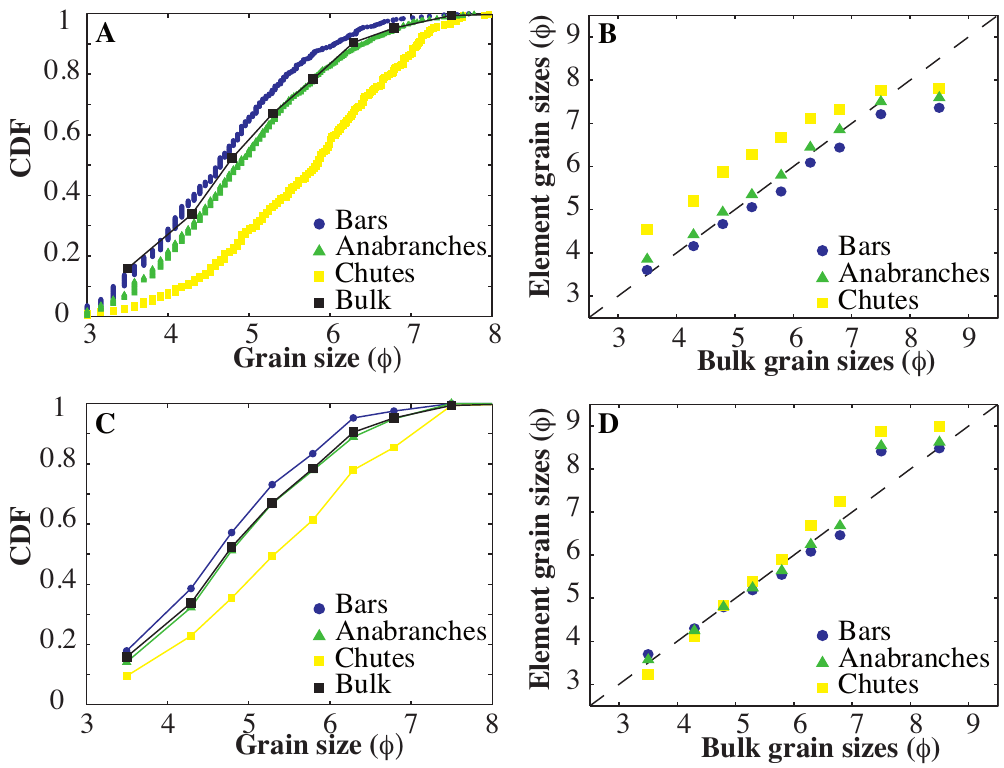
Fig. 6. Merged grain-size distributions of the sampled elements compared to the bulk distribution of the river bed. (a) Grain-size distribution and (b) Q-Q plots for the surface samples. (c) Grain-size distribution and (d) Q-Q plots for the surface-layer samples. The grain-size distribu- tions of the bars (blue dots) and the anabranches (green triangle) are quite similar, both in values and shapes, and compare well with the bulk distribution (black squares). In contrast, the grain-size distributions of the chutes (yellow squares) are clearly different from the anabranch, bar and the bulk distributions. This difference is more marked for the surface material ( a and b ) than for the surface layer ( c and d